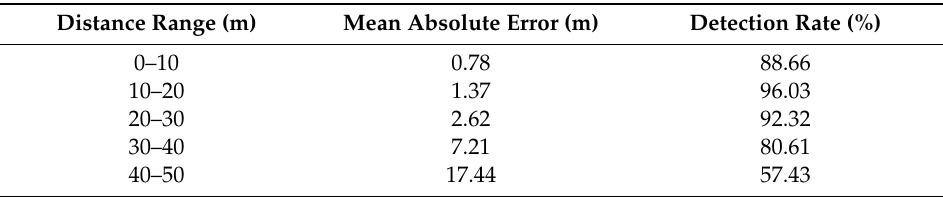
Table 5. MAE and detection rate compared with a stereo-vision-based sequence.